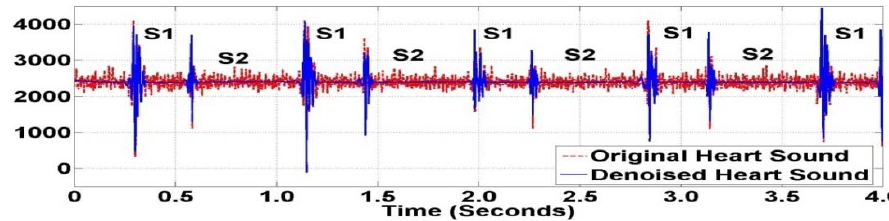
Figure 12. Original and Denoised Heart Sounds using Daubechies